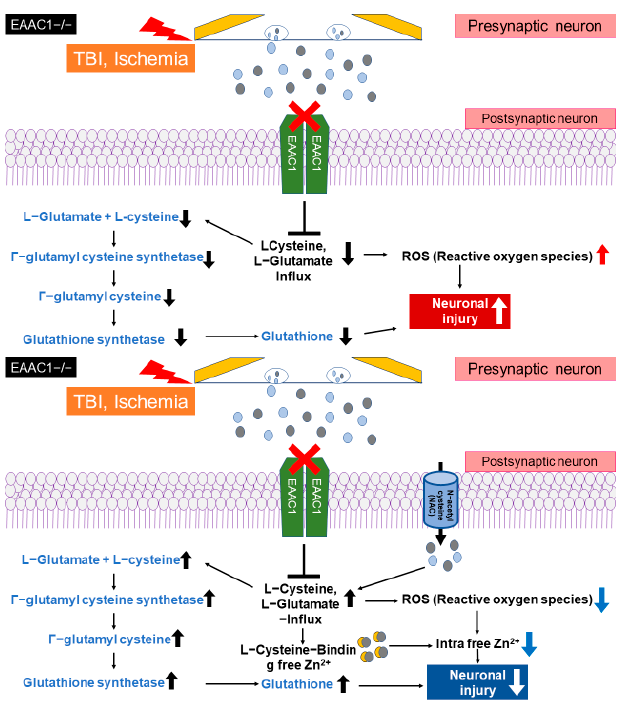
Figure 3. Traumatic brain injury or ischemic stroke when EAAC1 knockout inhibits cysteine trans- location [13,73]. Deletion of EAAC1 induced loss of L-cysteine and L-glutamate uptake, and ROS- mediated neuronal damage was preserved [13,73]. NAC can bind to presynaptically released zinc, and cysteine supplementation promotes enhanced GSH synthesis and zinc binding [13,73]. 5. The Role of Glutathione in Zinc-Induced Neuron Death after Brain Injury and cysteine supplementation promotes enhanced GSH synthesis and zinc binding